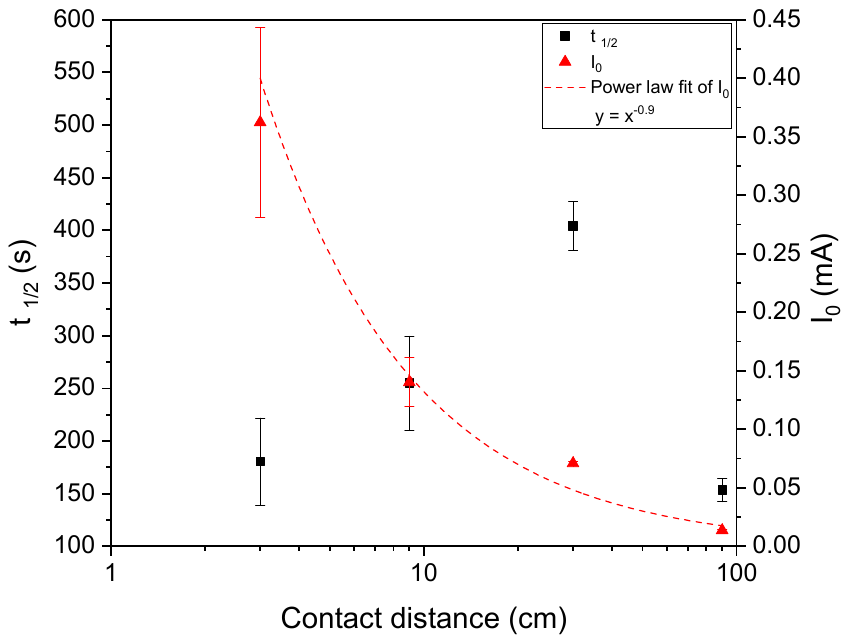
Figure 7. Dependence of the parameter t 1 / 2 and the value I 0 on the contact distance along with a power function fit for I 0 data for contact distances 3, 9, 30, and 90 cm with data points corresponding to mean values and their standard deviation values (error bars) from three experiments.